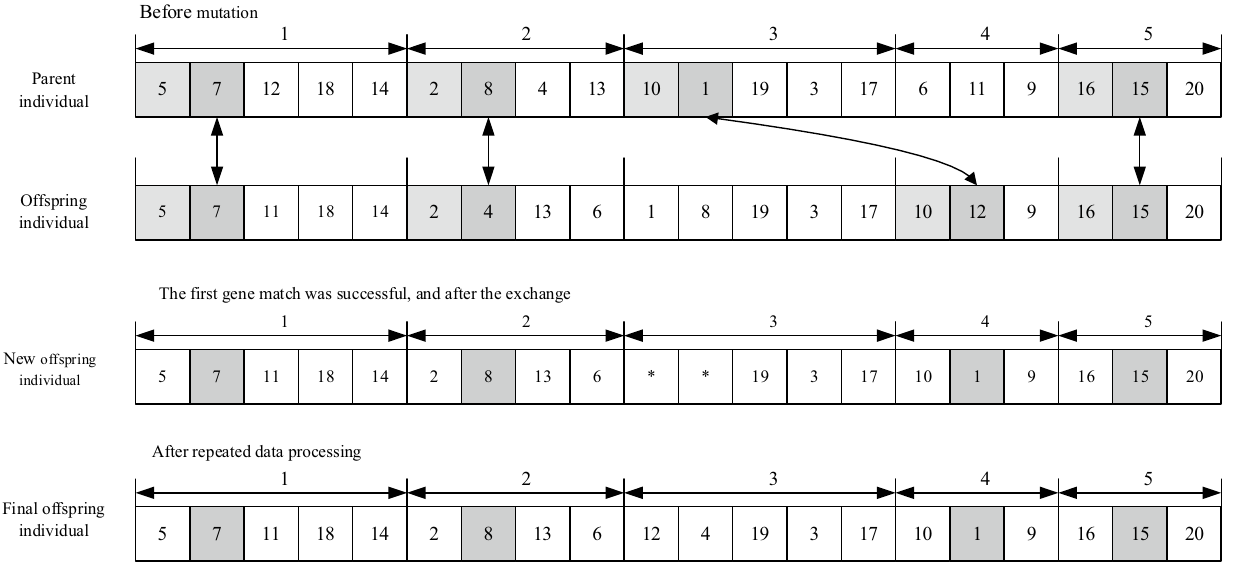
Fig. 3 Intra-group head-and-head